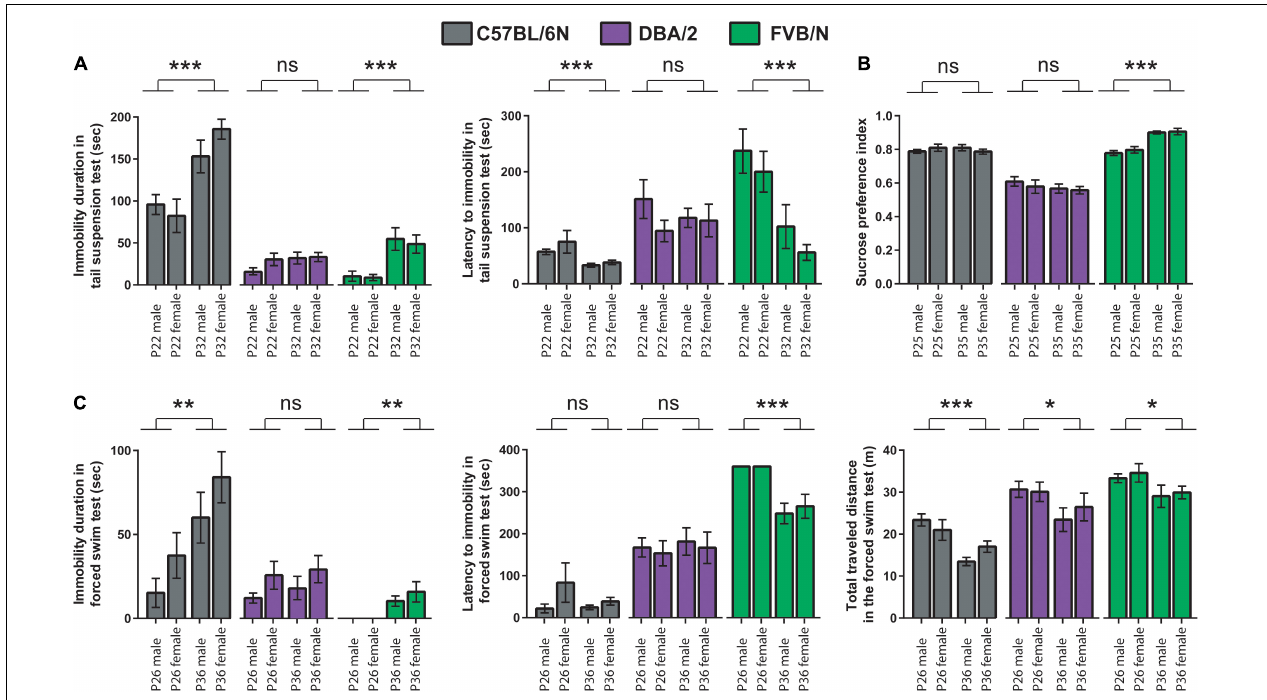
FIGURE 3 | Comparison between the P22–26 and P32–36 mouse cohorts within C57BL/6N, DBA/2, and FVB/N strains. (A) In the tail suspension test, P32 C57BL/6N and P32 FVB/N mice showed a significantly increased immobility duration and decreased latency to first immobility compared to P22 C57BL/6N and P22 FVB/N mice, respectively. (B) In the sucrose preference test, FVB/N mice showed an increased sucrose preference index in older compared to younger mice with no effect of age on C57BL/6N and DBA/2 strains. (C) In the forced swim test, P36 C57BL/6N and P36 FVB/N mice showed a significantly increased immobility duration compared to P26 C57BL/6N and P26 FVB/N mice, respectively. For the latency to the first immobility, only P36 FVB/N mice showed a significantly decreased latency to the first immobility compared to P26 mice. For the total traveled distance, all three strains showed a decreased traveled distance in older compared to a younger age. Two-way ANOVA followed by Tukey post hoc test,* p ≤ 0.05, ** p ≤ 0.01, and *** p ≤ 0.001. Error bars indicate the standard error of the mean